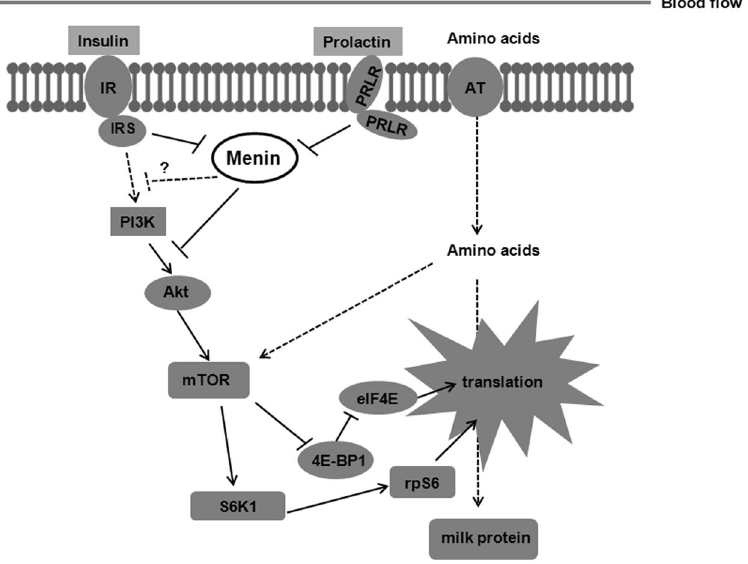
Figure 6. Mediation by Menin of milk protein synthesis through the PI3K/Akt/mTOR signaling pathway in mammary epithelial cells. Hormones such as insulin and prolactin that acts on epithelial cells modulate the MEN1 /Menin expression level in cells, which further affects the abundance of the factors involved in mTOR signaling and eventually the synthesis of milk protein. Please see the text for further details. PI3K, phosphatidylinositol-3-kinase; Akt, also known as protein kinase ( B ) mTOR, mammalian target of rapamycin; IR, insulin receptor; IRS, IR substrate; PRLR, prolactin receptor; AT, amino acid transporter. The solid line represents fluxes; the dotted line represents possible effects or